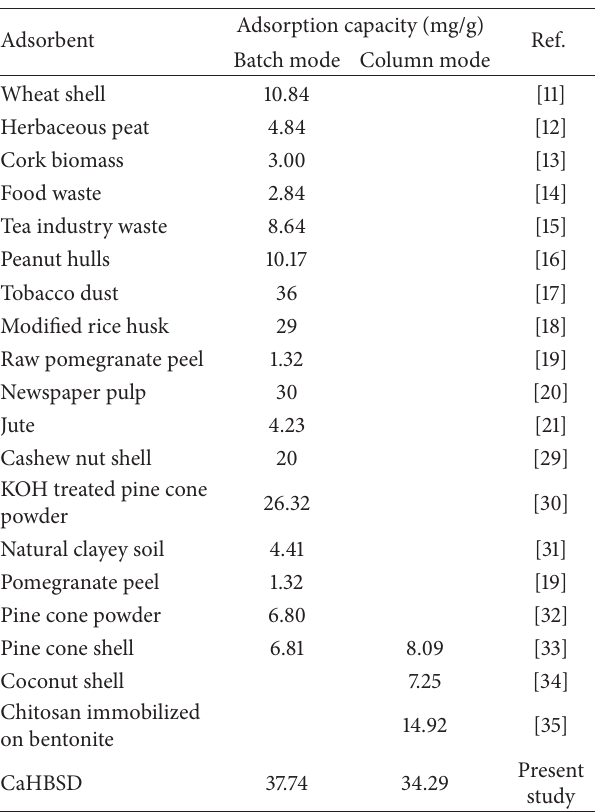
Table 3: Comparison of adsorption capacities of CaHBSD with some low-cost adsorbents.